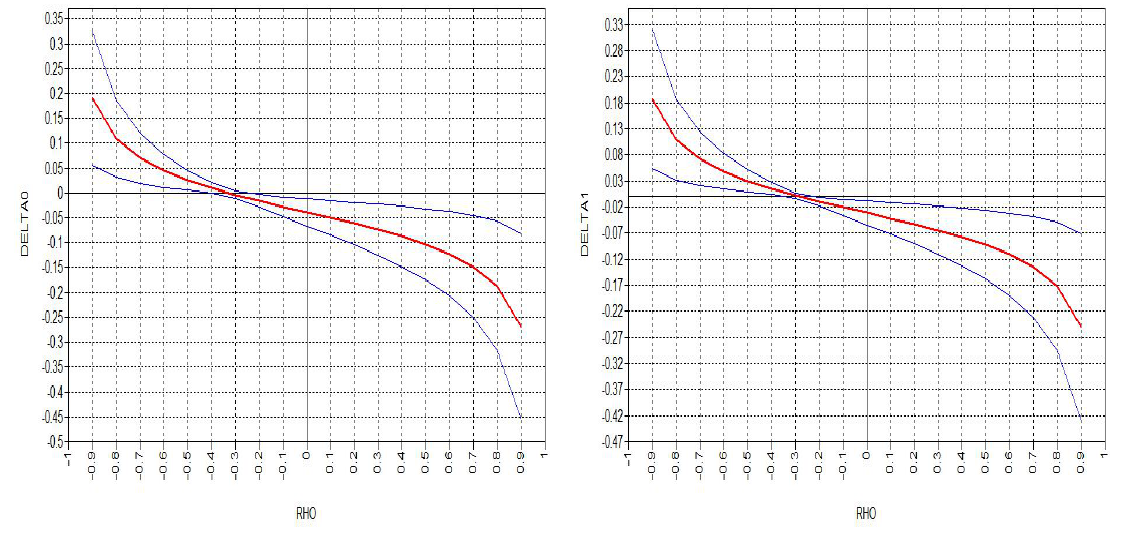
Figure 3: Sensitivity of the mediated or unmediated portions of ITT effects to the violation of LSI